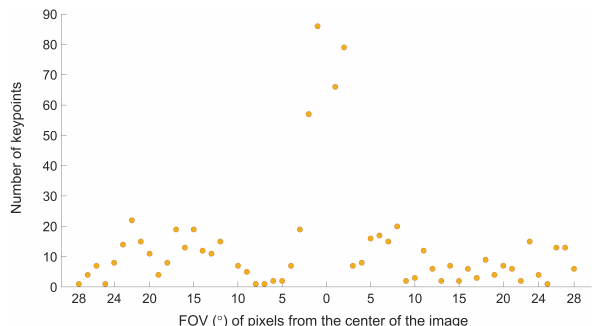
Figure 10. keypoints across the FOV for the image acquired at 6m and ψ = 45º for corner site